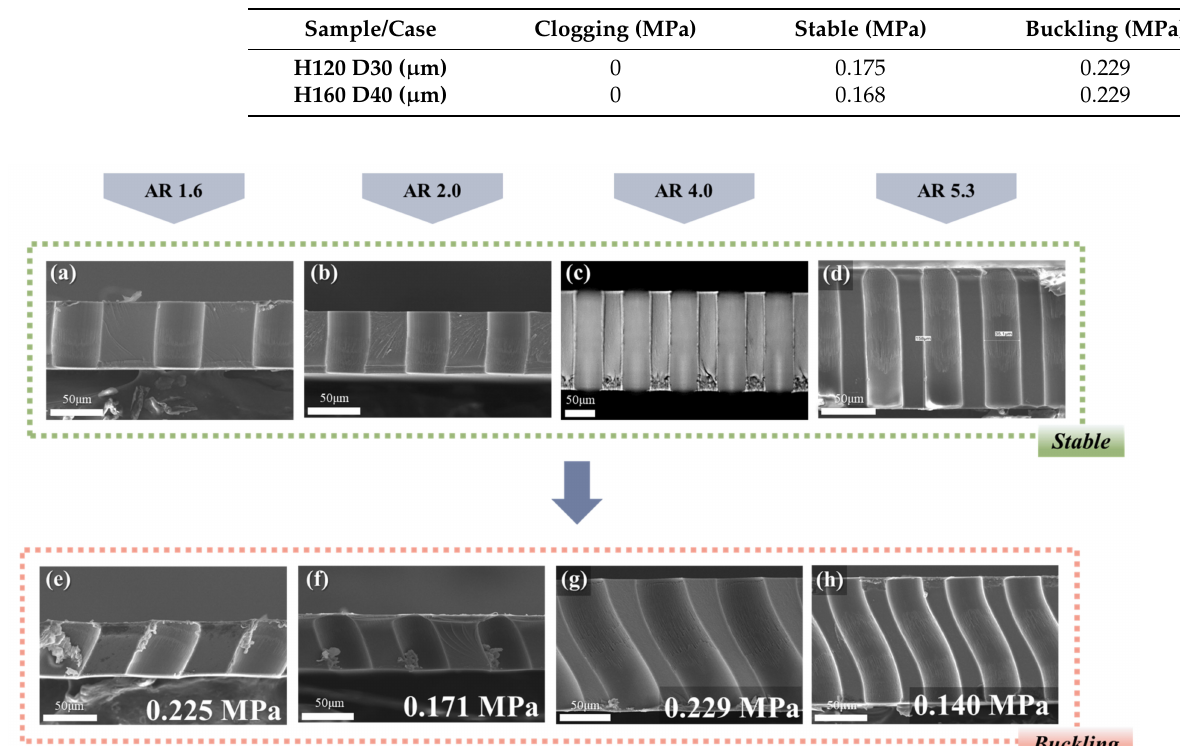
Figure 5. ( a – h ) SEM and OM images of constructed polymeric stencil membranes with varying aspect ratios. Polymeric stencil membranes in stable state ( a – d ), and in buckled state with structural AR of 1.6, 2.0, 4.0, and 5.3 ( e – h